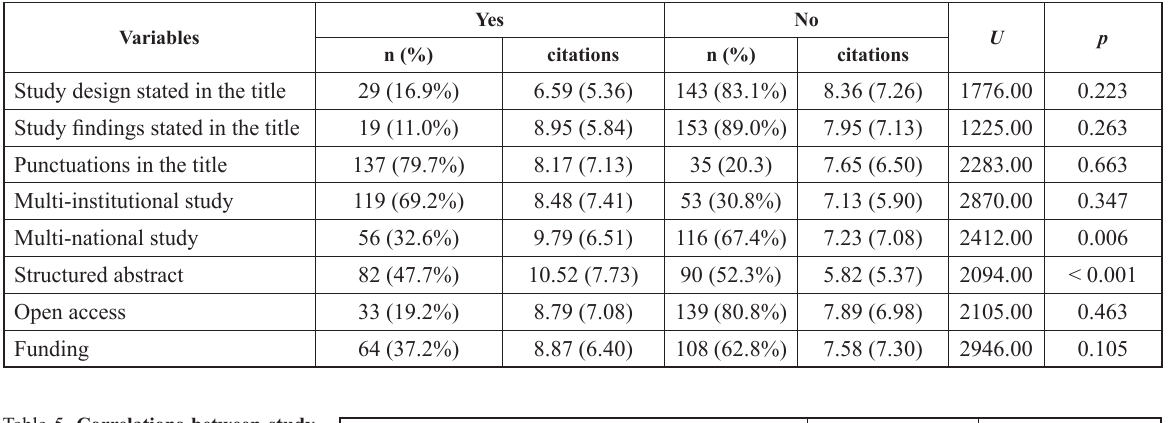
Table 5. Correlations between study variables and number of